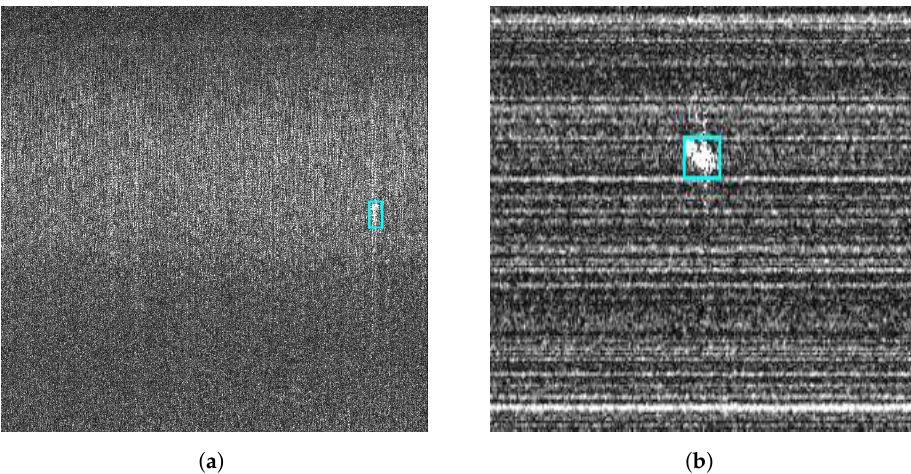
Figure 5. The third and fourth images for quantitative analysis, which contain narrowband RFI. ( a ) Sentinel-1 image, ( b ) Gaofen-3